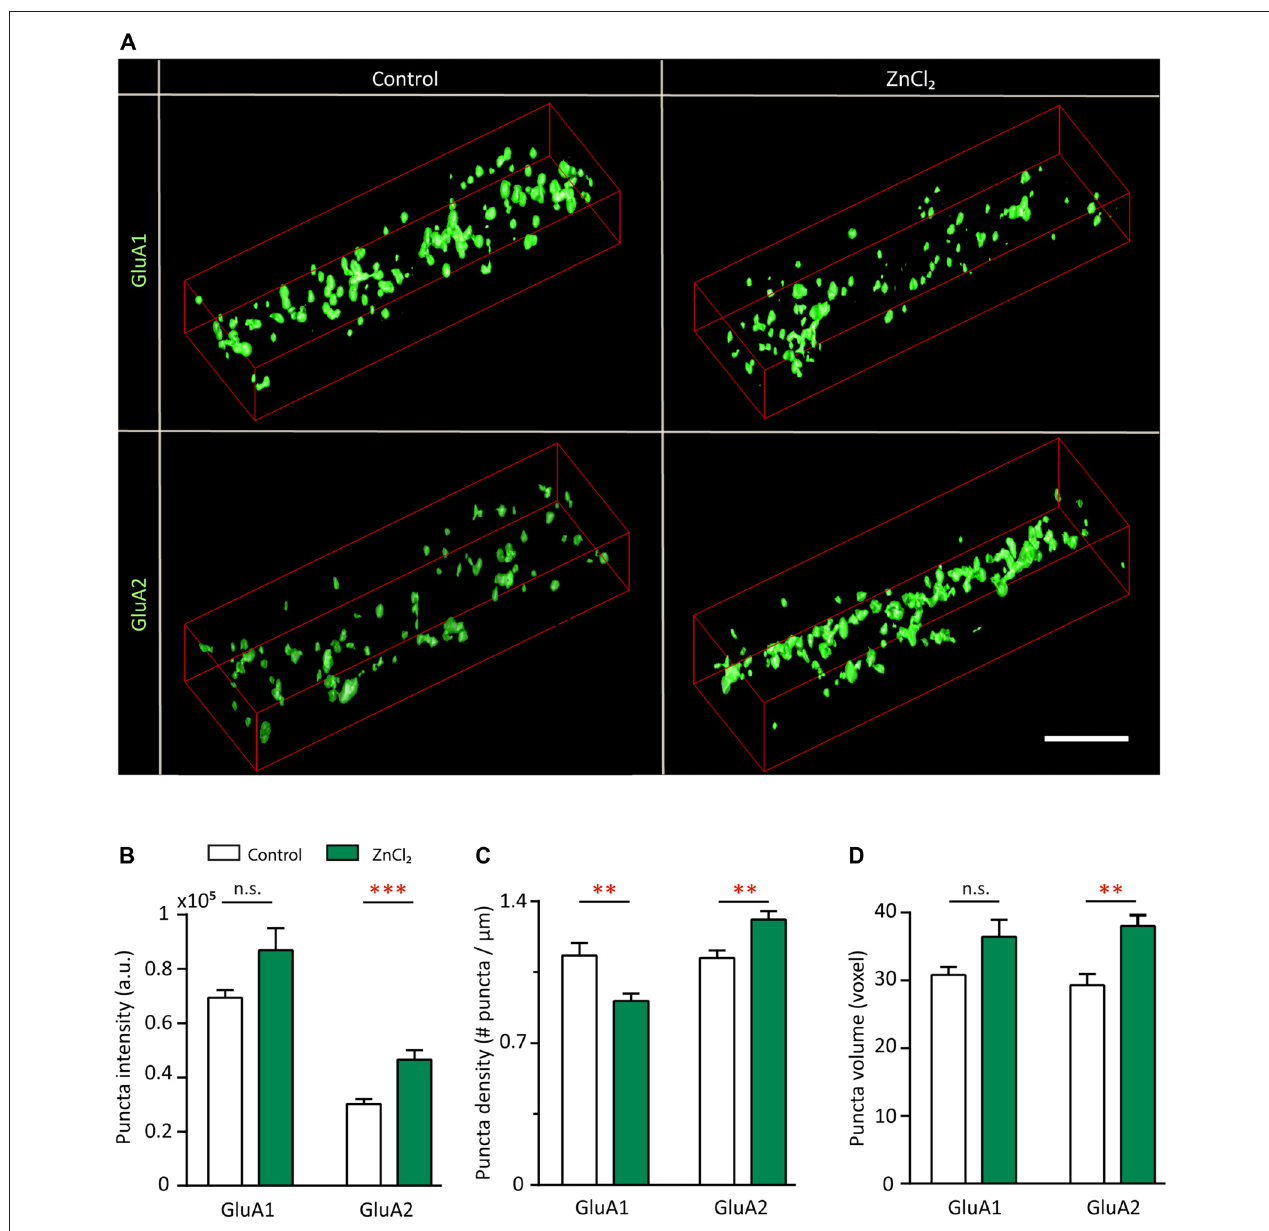
FIGURE 7 | Zinc treatment recruits surface GluA2 and disperses surface GluA1. (A) Straightened dendrites from young hippocampal neurons (DIV 14) treated with control (left) or 10 µ M ZnCl 2 (right) conditions. Neurons were live surface labeled for GluA1 (top) or GluA2 (bottom). Scale bar: 4 µ m. (B–D) Summary graphs showing quantification of GluA1 and GluA2 puncta intensity (B) , density (C) and volume (D) [mean ± SEM; Mann-Whitney test for GluA1, N = 19 (control), 22 (ZnCl 2 ) dendrites from 10 to 14 neurons from two culture preps; for GluA2, N = 24 dendrites from 10 to 14 neurons from two culture preps; n.s. p ≥ 0.05, ∗∗ p < 0.01, ∗∗∗ p <